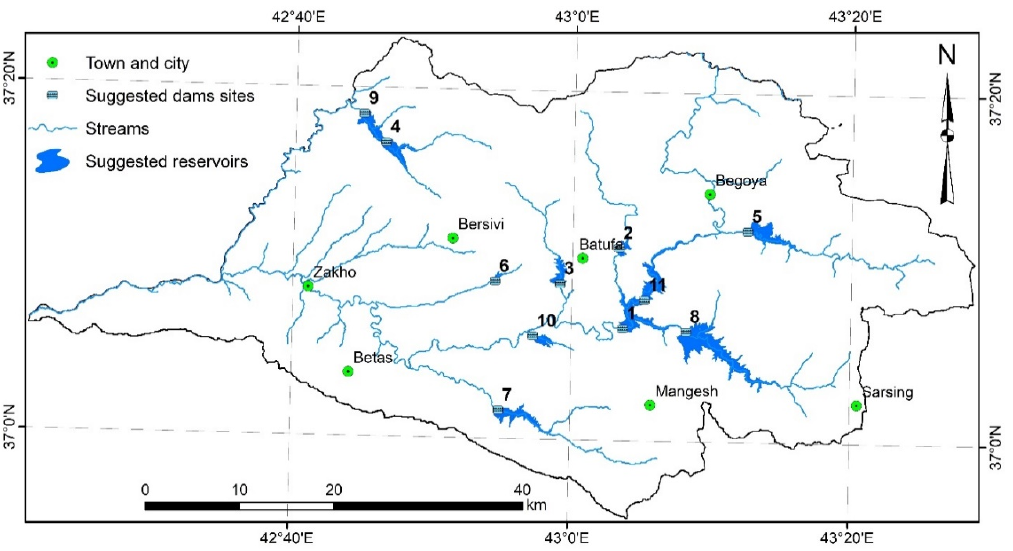
Figure 16. Suggested dam sites based on AHP and WSM models.